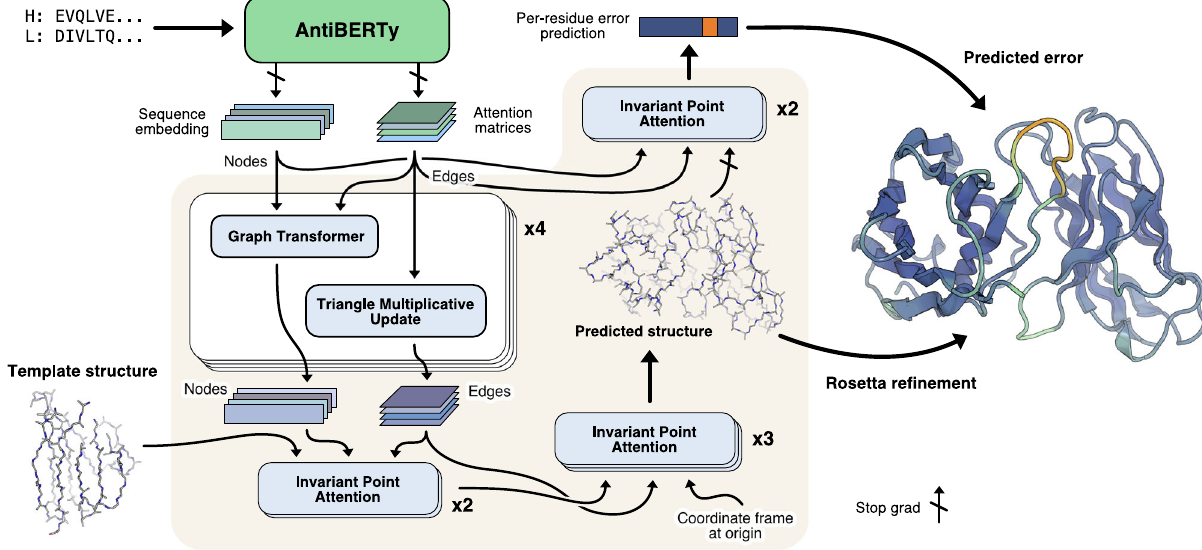
Fig. 1 | Diagram of method for end-to-end prediction of antibody structures. AntibodysequencesareconvertedintocontextualembeddingsusingAntiBERTy,a pre-trained language model. From these representations, IgFold uses a series of